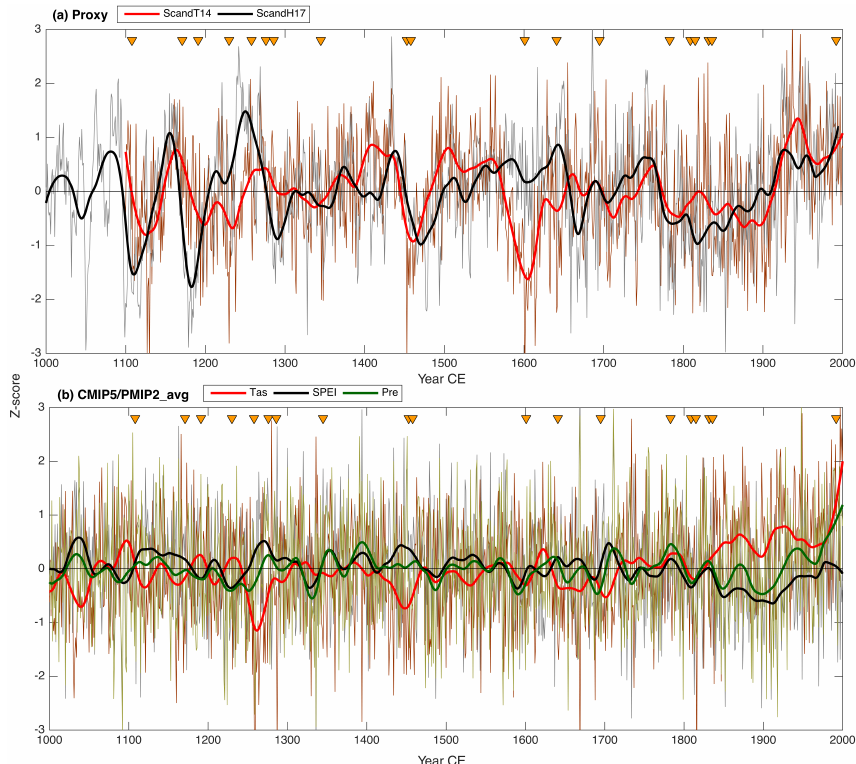
Figure 7. Time series of (a) ScandH17 and ScandT14, and (b) GCM (r1i1p1 ensemble) average temperature, precipitation and SPEI. Smoothed time-series using a 50-year loess filter are shown as thick lines. Individual model data are provided in the Supplement (Fig. S8). The years with volcanic eruptions from Table 3 are indicated by triangle